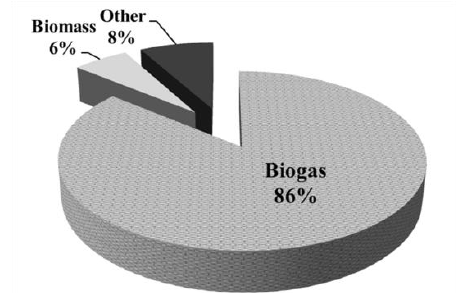
Fig. 1. Number of CDM projects registered in Thailand in